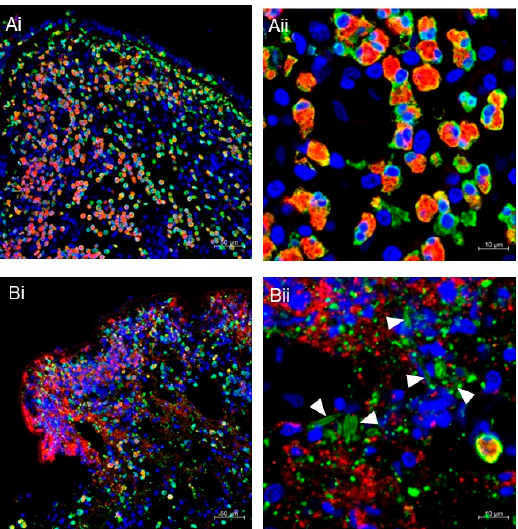
Figure 2. ( A , B ) Immunofluorescence staining of nasal polyps from patients with chronic rhinosinusitis with nasal polyps. Fluorescence images for MBP (red), galectin-10 (green), and DNA (blue) were obtained using a Carl Zeiss LSM780 confocal microscope, as previously described [36] . Intact eosinophils are massively infiltrated in polyps ( Ai , Aii ). The presence of ETotic eosinophils with extracellular traps (degenerated DNA), cell-free granules (punctate MBP), extracellular vesicles (punctate galectin-10), and CLCs (galectin-10-stained needle-like crystals; arrowheads) can be seen ( Bi , Bii ). Scale bars: 50 μ m for ( i ) and 10 μ m for ( ii ).